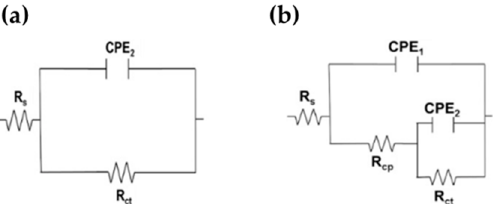
Figure 11. Equivalent circuits proposed for SS 430 ( a ) and carbon steel B450C ( b ) exposed to chloride-containing cement extract solution up to 720 h (30 days).